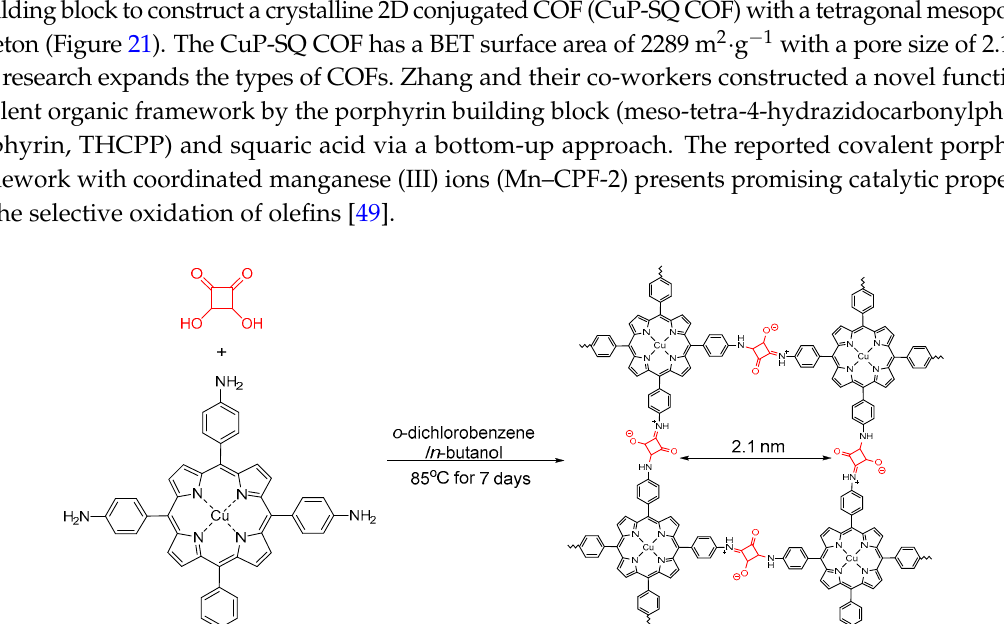
Figure 22. Construction of imide-linked COFs by stitching tritopic or tetratopic polyaniline with benzene-1,2,4,5-tetracarboxylic dianhydride into 2D and 3D networks.